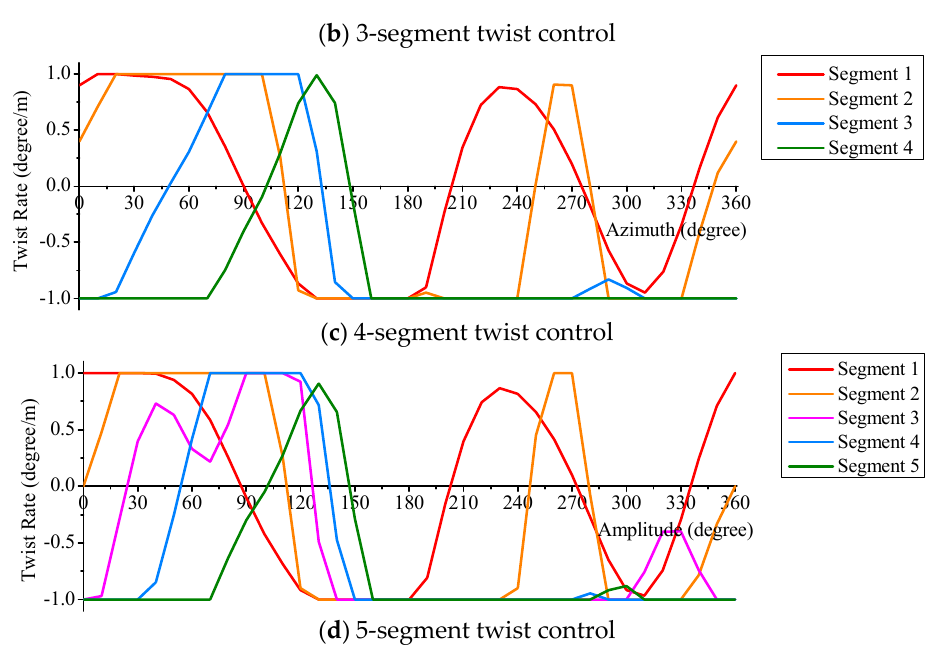
Figure 22. Optimal control schedules of the segment twist control for condition B. For the configurations of 4- and 5-seg control, some adjacent control segments have similar control schedules. For these two configurations, the control schedules from 0.5 L to 0.6 L are similar to that in the innermost segment. Additionally, the control schedule from 0.6 L to 0.9 L are similar to those in the middle segment of the 3-seg control configuration. Figure 23 shows the distribution of the drag load increment relative to the baseline rotor using segment control. The effects of 4- and 5-seg control are basically similar to those of 3-seg control. Some local load distributions are further optimized. Thus, too many control segments may not yield further benefits, but may be penalized with an increase in system complexity. For the four selected conditions of the UH-60A helicopter model, the segment twist control achieves greater power reduction than the uniform twist control, and the 2- and 3-seg control configurations are appropriate.